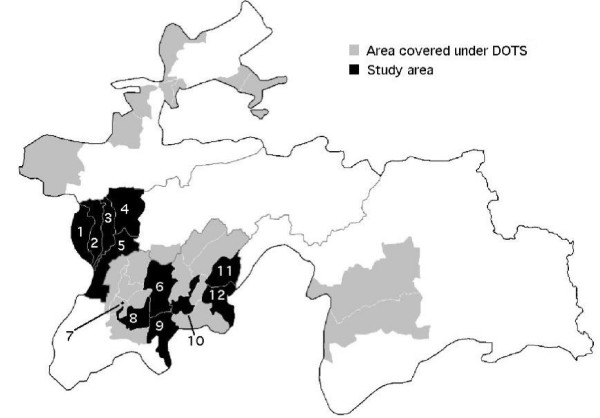
Location of study districts among all districts with a DOTS program in July 2006 in Tajikistan. District codes: 1 = Tursunzoda, 2 = Shahrinaw, 3 = Hissor, 4 = Varzob, 5 = Rudaki, 6 = Danghara, 7 = Qurghonteppa, 8 = Vakhsh, 9 = Farkhor, 10 = Vose, 11 = Muminobod, 12 = Shurobod.